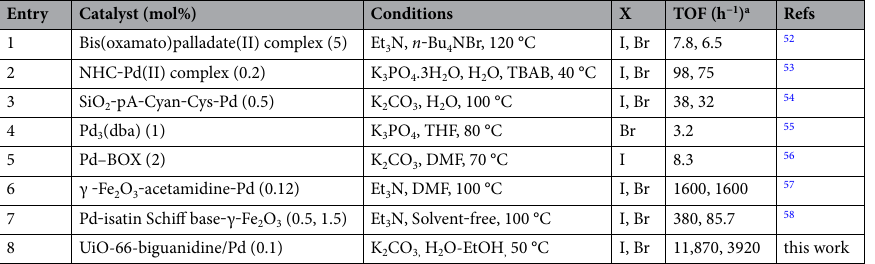
Table 8. Catalytic Comparison in the reaction between phenyl boronic acid and iodobenzene. a TOF, turnover frequencies (TOF = (Yield/Time)/Amount of catalyst